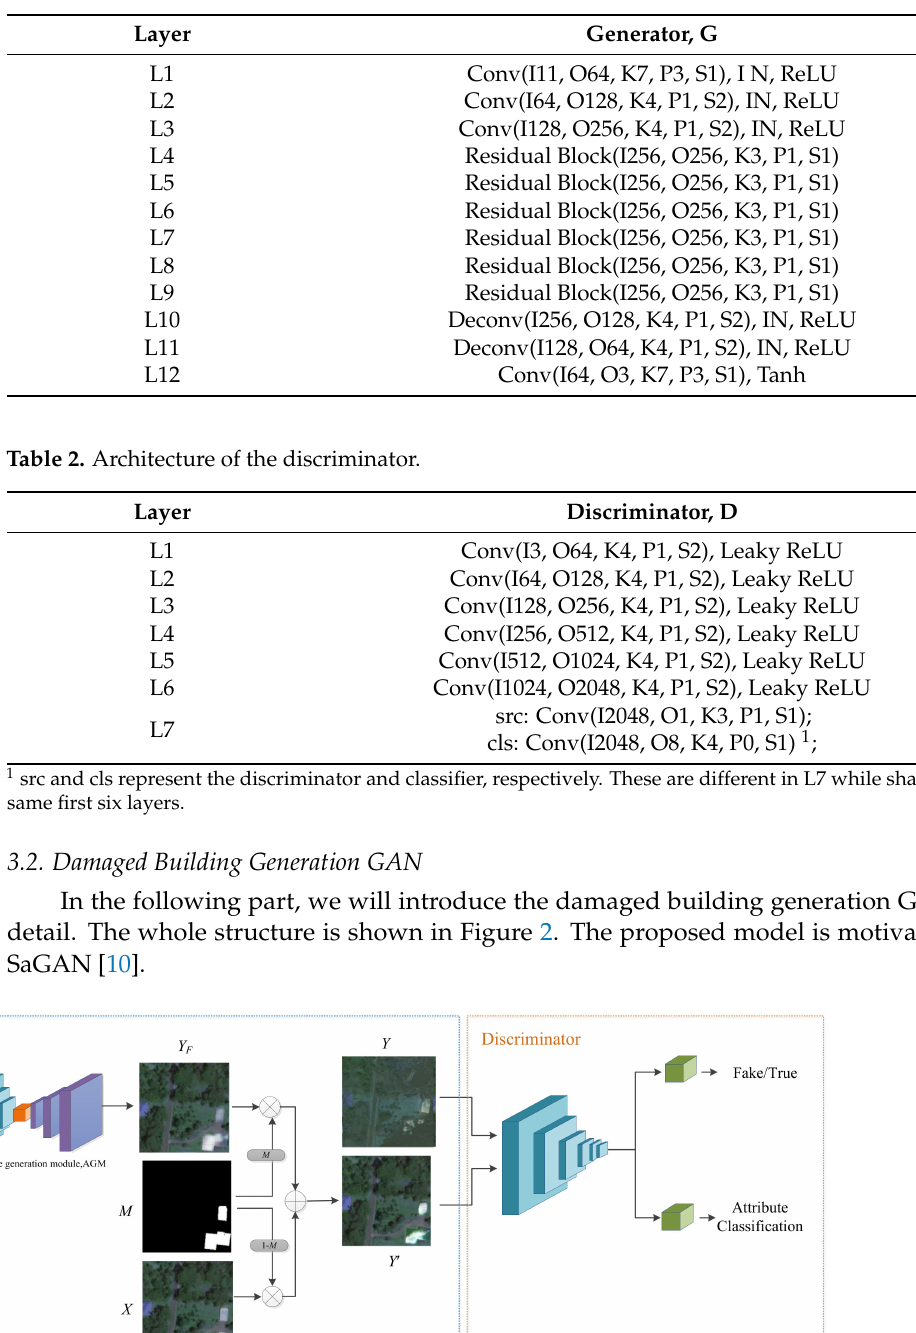
Table 1. Architecture of the generator.